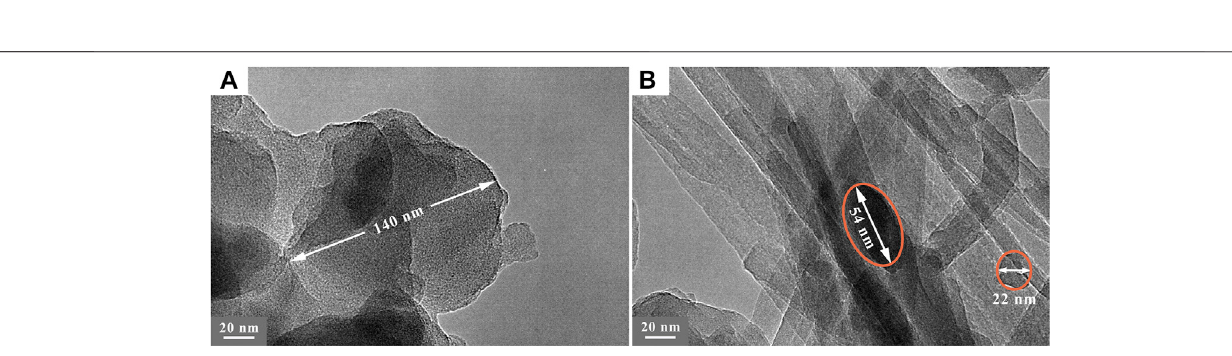
FIGURE 2 | SEM images of (A) SEP, (B) nZVI, (C, D) nZVI/SEP composites and (E) the element mapping of nZVI/SEP composites.